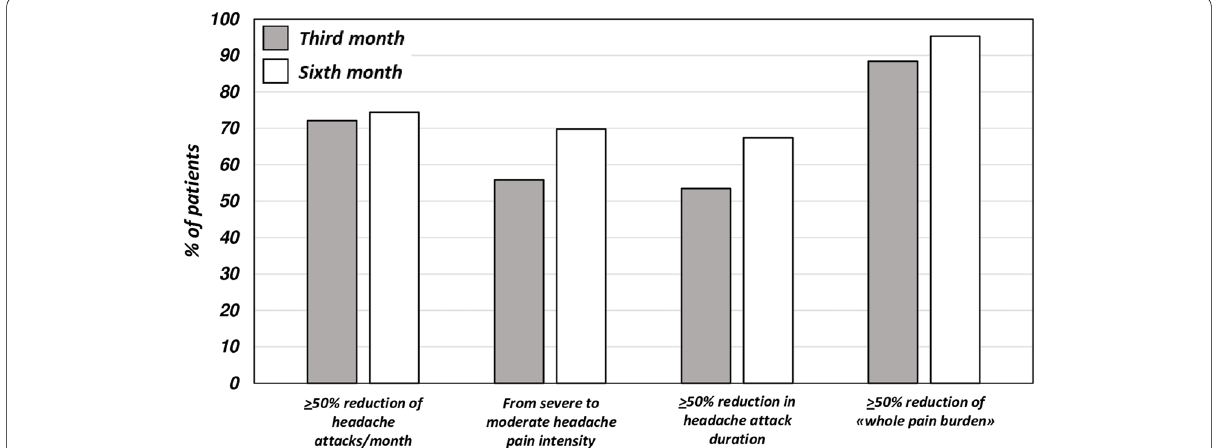
Fig. 2 Percentage of patients reporting a > 50% reduction in headache attacks frequency, pain intensity, headache attacks duration and “whole pain burden” score at the end of the third (T 1 ) and sixth month (T 2 ) galcanezumab